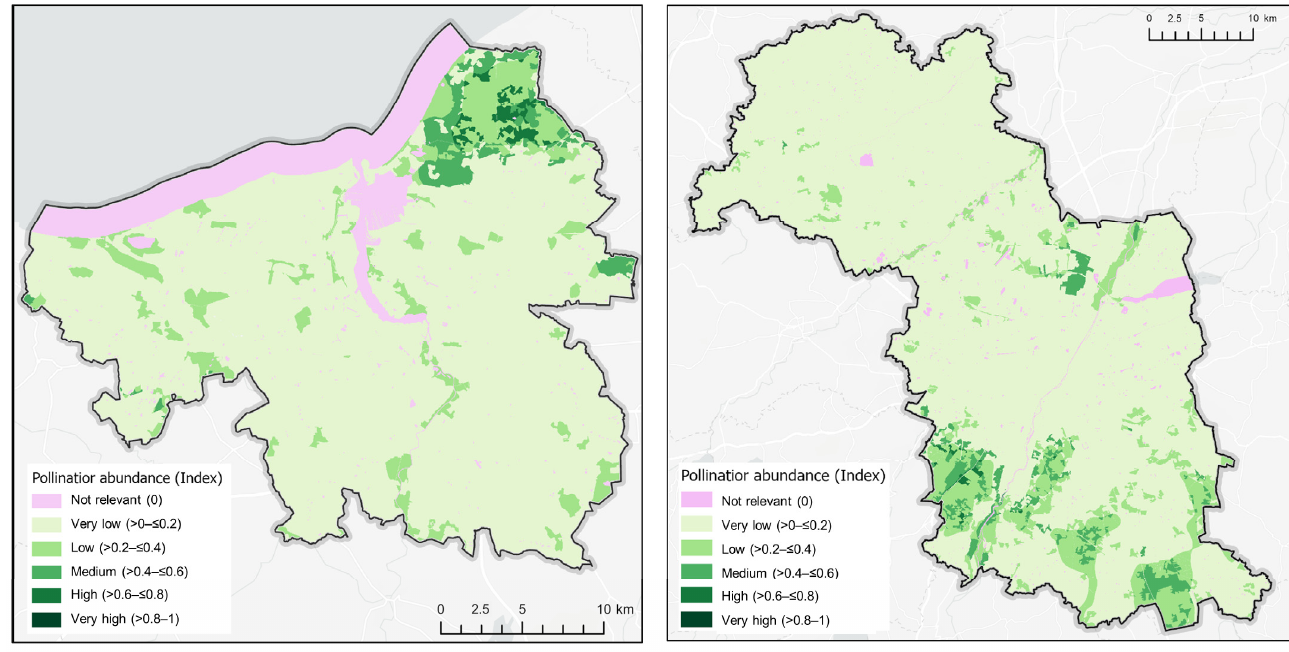
Figure 5. Spatial patterns of pollination supply in the urban regions of Rostock and Munich, modelled with the InVEST model Pollinator Abundance: Crop Pollination.